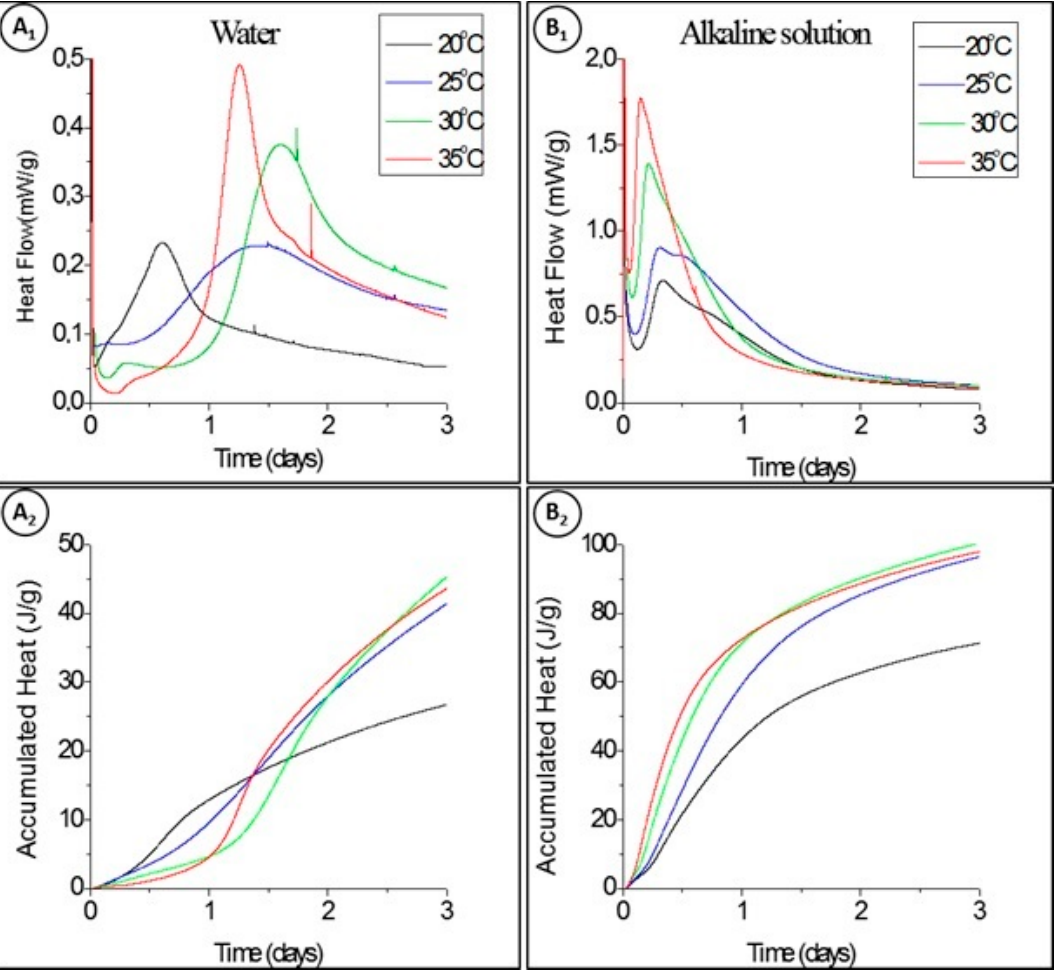
Figure 1. Heat release ( A 1 , B 1 ) and accumulated heat release ( A 2 , B 2 ) in function of time at different temperatures, with different hydration solutions: water ( A 1 , A2 ) and alkaline solution ( B 1 , B 2 ). A best-fit line was adjusted to the acceleration period in order to obtain the “k” term of Equations (1) and (2) through the slope of the fitting equation. The fits were performed in all the experiments made either with pastes hydrated with water or with alkali- activated pastes. Figure 2 presents an example of a calorimetric curve with the respective best-fit linear analysis for the 35 °C alkali-activated sample.